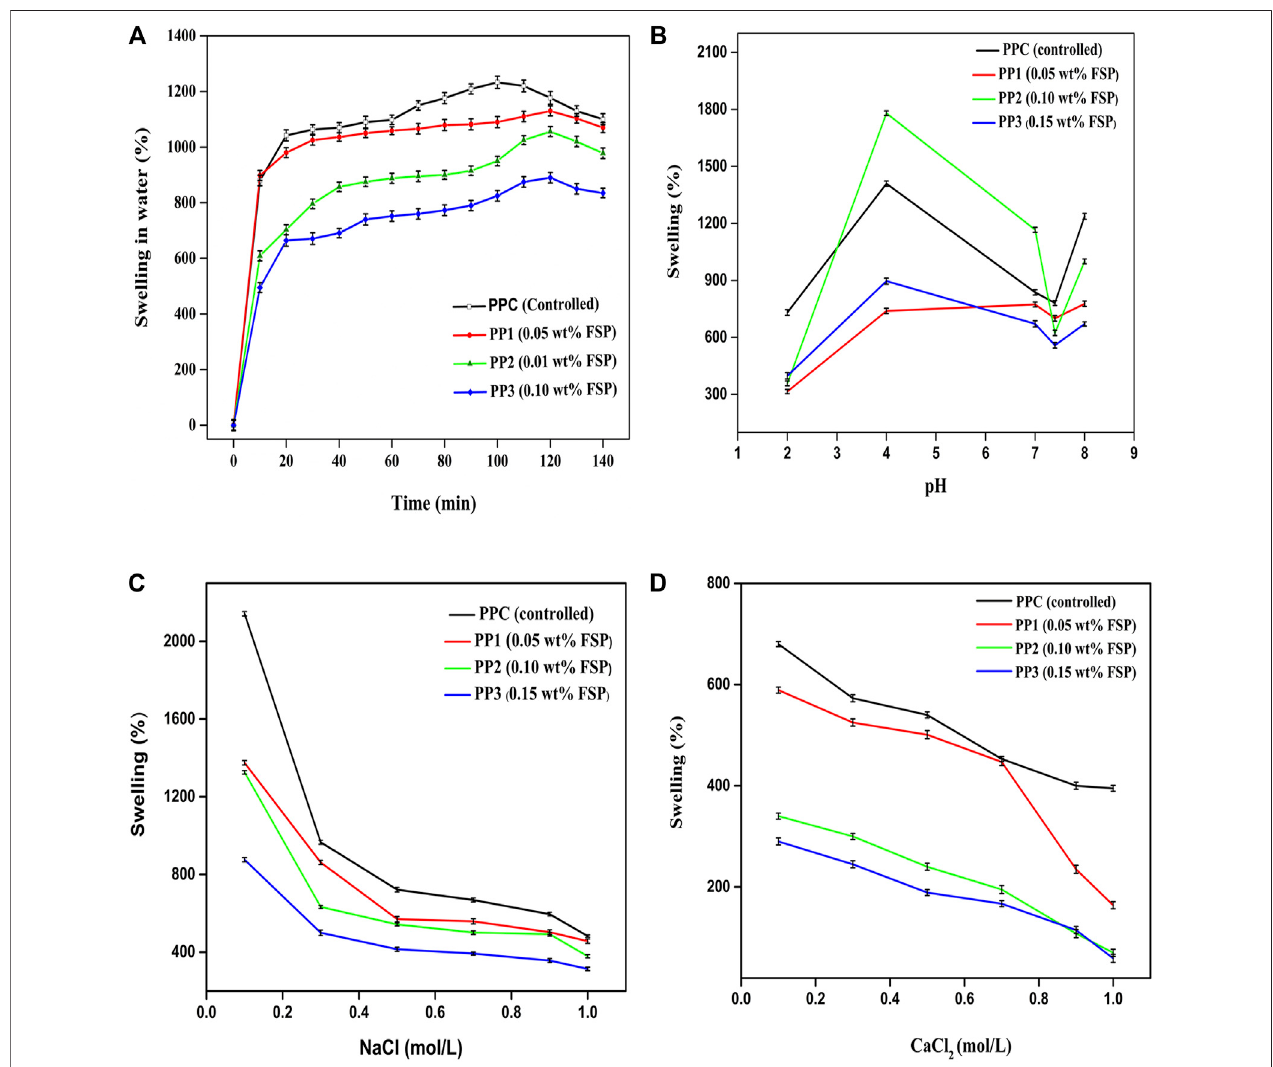
FIGURE 3 | (A) Time-dependent swelling behavior of PP hydrogel in water (B) pH-sensitive swelling response of PP hydrogels (C) swelling response of PP hydrogels against NaCl (D) swelling response of PP hydrogels against CaCl 2 .